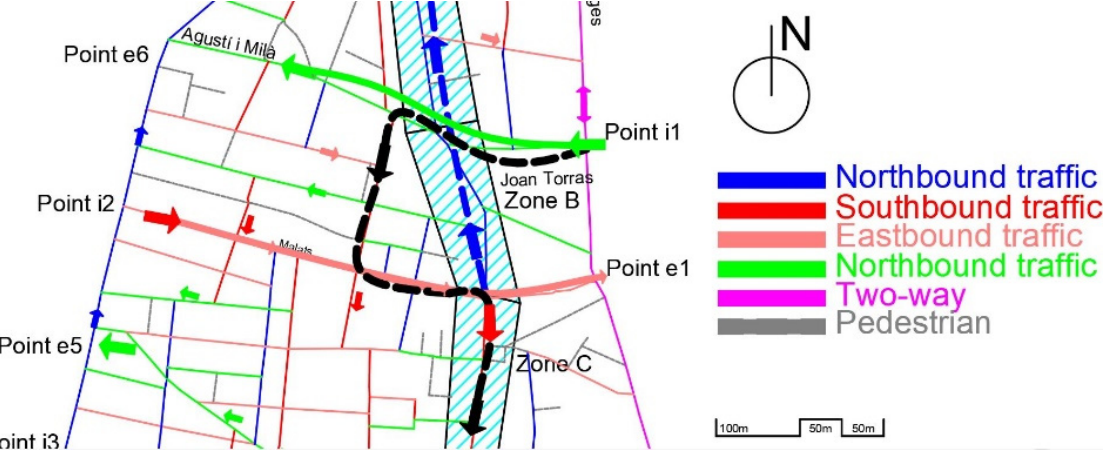
Figure 5. Street configuration after the pacification, where in black we can see the route to arrive at the center of the neighborhood .